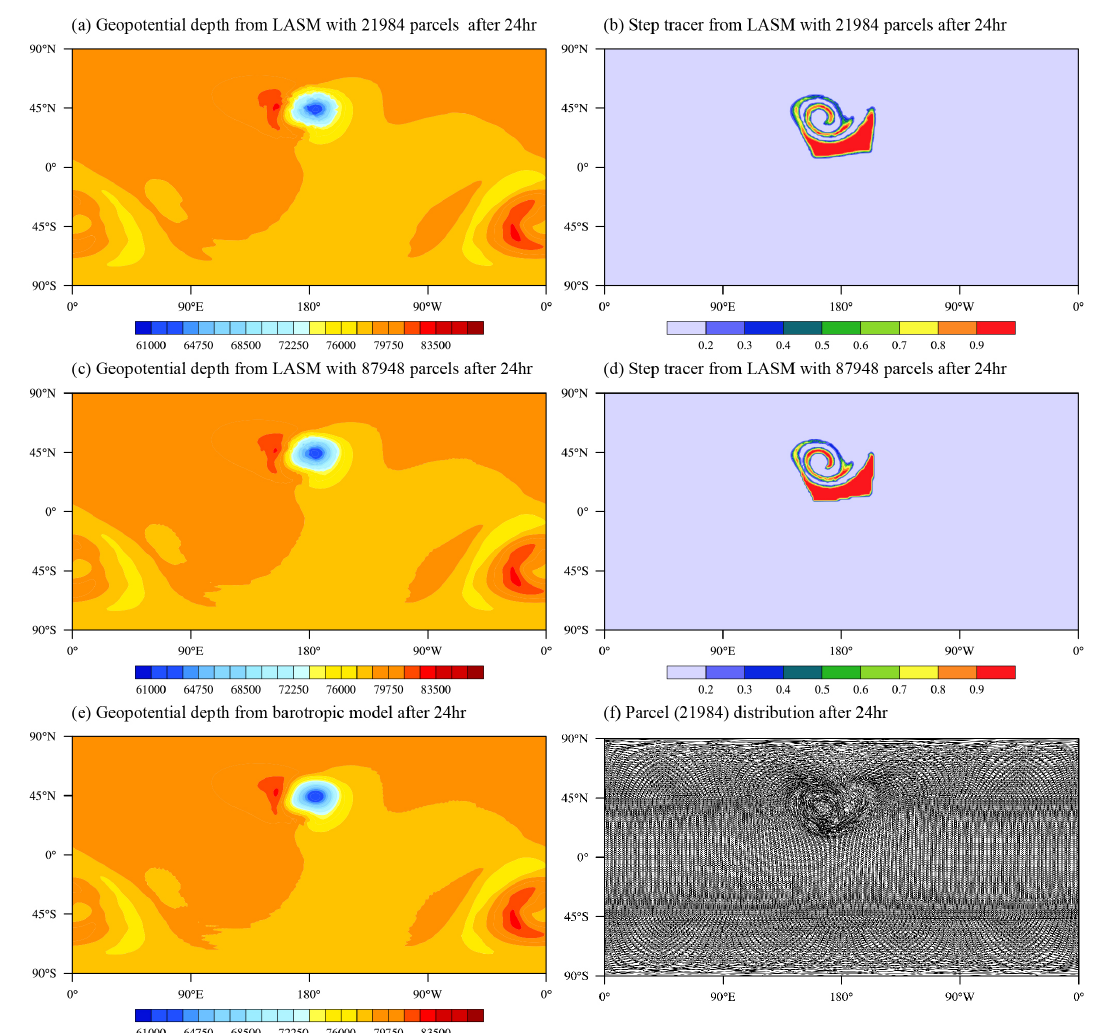
Figure 15. The simulation results after 24h in subcase